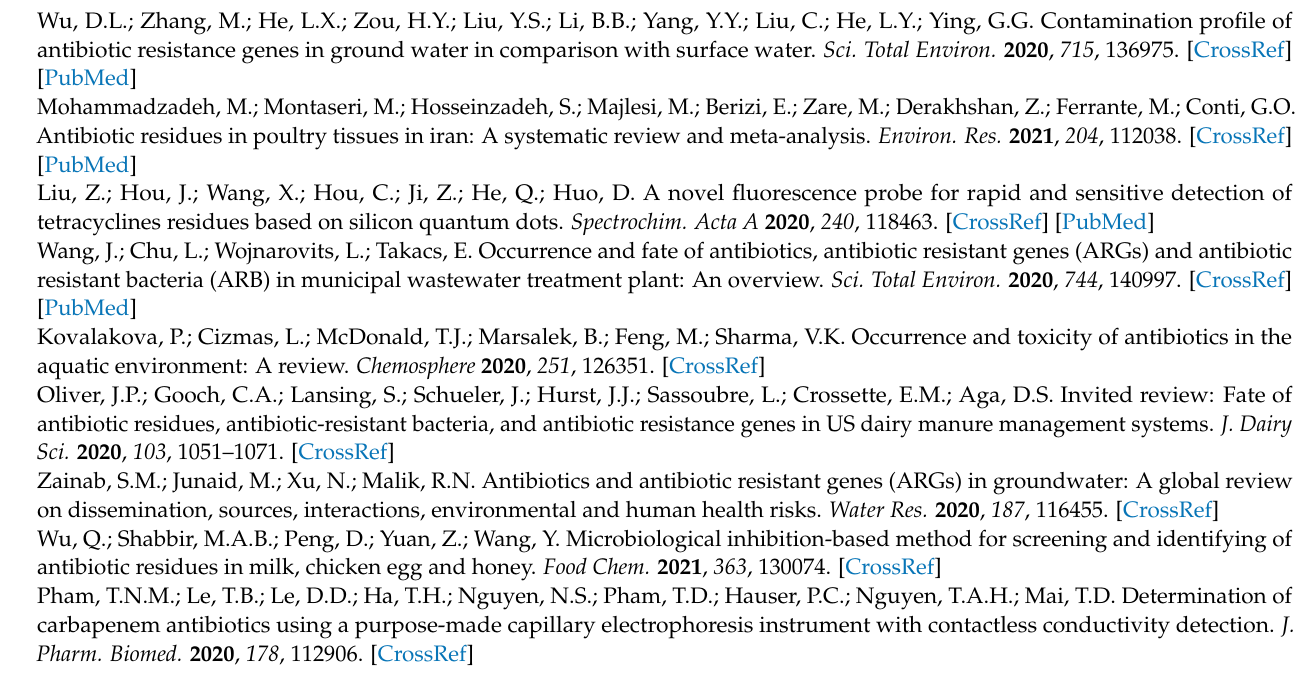
dose-response curves for TC detection using (a) AuNCs, (b) AuNCs-Cu 2+ , (c)AuNCs-Fe 3+ , (d) AuNCs- Fe 2+ , (e) AuNCs, (f) AuNCs-Ag + reaction system, between the absorbance at 452 nm against the logarithmic concentration of TC; Figure S5: The dose-response curves for OTC detection using (a) AuNCs, (b) AuNCs-Cu 2+ , (c)AuNCs-Fe 3+ , (d) AuNCs-Fe 2+ , (e) AuNCs, (f) AuNCs-Ag + reaction system, between the absorbance at 452 nm against the logarithmic concentration of OTC; Figure S6: The dose-response curves for CTC detection using (a) AuNCs, (b) AuNCs-Cu 2+ , (c)AuNCs-Fe 3+ , (d) AuNCs-Fe 2+ , (e) AuNCs, (f) AuNCs-Ag + reaction system, between the absorbance at 452 nm against the logarithmic concentration of CTC; Figure S7: The dose-response curves for Cip detection using (a) AuNCs, (b) AuNCs-Cu 2+ , (c)AuNCs-Fe 3+ , (d) AuNCs-Fe 2+ , (e) AuNCs, (f) AuNCs-Ag + reaction system, between the absorbance at 452 nm against the logarithmic concentration of Cip; Figure S8: The dose-response curves for Van detection using (a) AuNCs, (b) AuNCs-Cu 2+ , (c)AuNCs- Fe 3+ , (d) AuNCs-Fe 2+ , (e) AuNCs, (f) AuNCs-Ag + reaction system, between the absorbance at 452 nm against the logarithmic concentration of Van; Figure S9: The dose-response curves for GM detection using (a) AuNCs, (b) AuNCs-Cu 2+ , (c)AuNCs-Fe 3+ , (d) AuNCs-Fe 2+ , (e) AuNCs, (f) AuNCs-Ag + reaction system, between the absorbance at 452 nm against the logarithmic concentration of GM; Table S4: Summary of the fitting curve formula in Figures S4–S9; Table S5: Identification of unknown 18 antibiotics samples in river water; Table S6: Recovery results for antibiotics detection in river water samples using AuNCs-metal ions system; Table S7: LDA identification results of 11 mixture antibiotics and 6 antibiotics with different concentrations; Table S8: Identification of unknown 11 mixture antibiotics samples in river